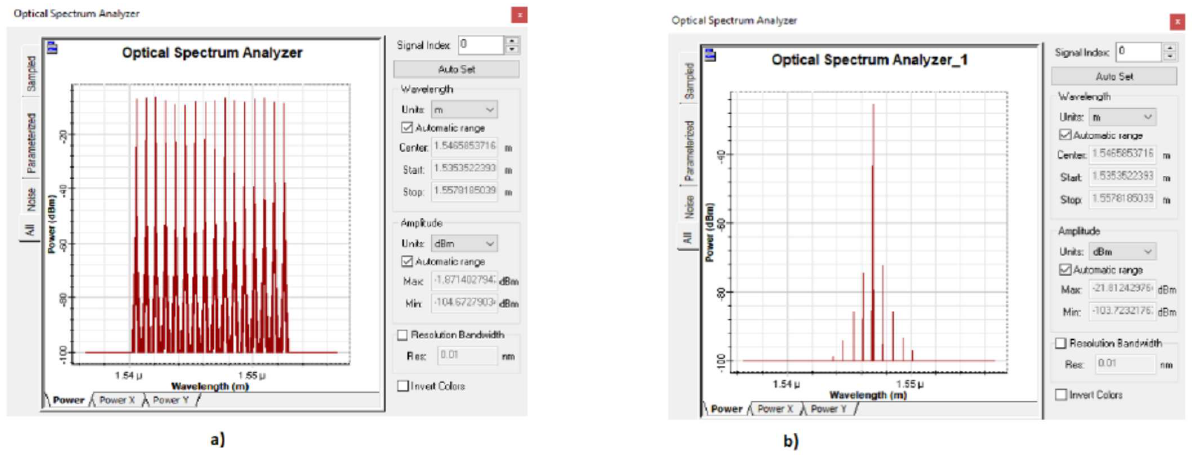
Figure 3. Results of 16-channel WDM spectral analysis simulation: a) transmitting side, b) receiving side filtered one